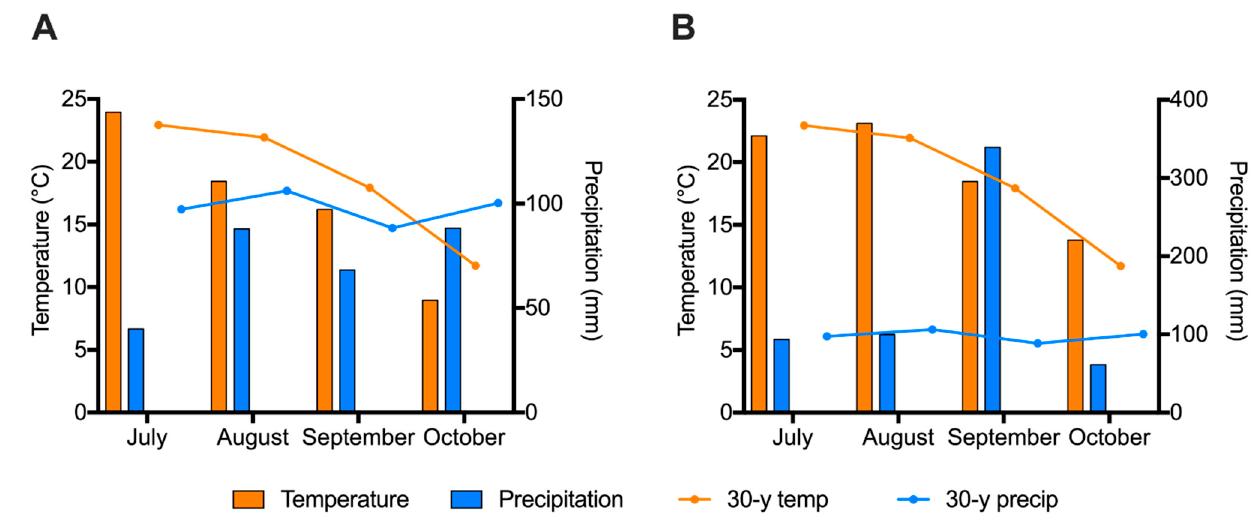
Figure 1. Monthly weather conditions at the experimental site. ( A ) 2020 and ( B ) 2021. 30-y temp: 30-year normal temperature at the experimental site; 30-y precip: 30-year normal precipitation at the experimental site.